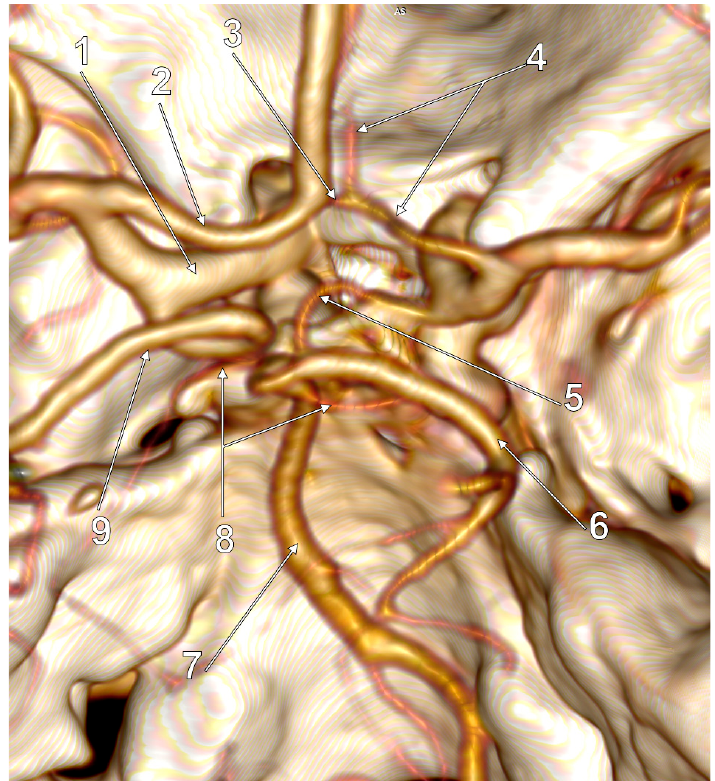
Figure 7. Posterior view of the cW. Full/complete left FPCAs (f-FPCA). Four variant sides of the cW: hypoplastic right ACA, hypoplasia of AComA, hypoplastic PComA and aplastic contralateral P1. 1. Left ICA; 2. A1 segment of the left ACA; 3. Hypoplasia of AComA; 4. Hypoplastic right ACA; 5. Hypoplastic right PComA; 6. Right PCA leaving the left side of the BA distal end; 7. BA; 8. Superior cerebellar arteries; 9. Coiled left f-FPCA. Table 2. Variant sides of the cW in cases with FPCA. M: male, F: female.